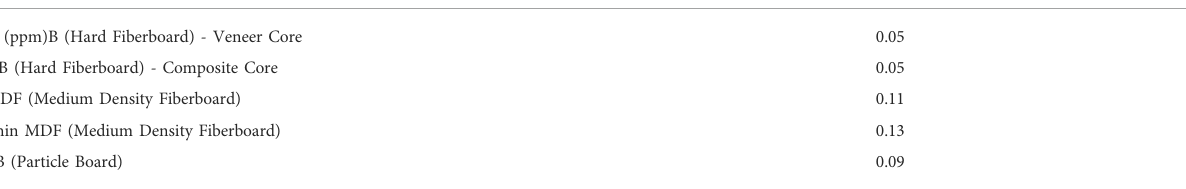
TABLE 2 EPA formaldehyde (HCHO) emission